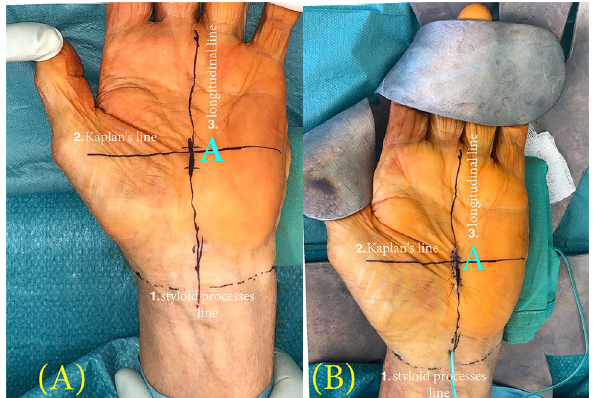
Figure 2. ( A ) Preoperative planning and ( B ) Postoperative result of MCTR: The following lines are drawn: 1. Horizontal line between both styloid processes 2. Horizontal parallel line—the Kaplans cardinal line: 3. Longitudinal line on the ring finger’s radial side. ( A ) The intersection point of these two lines (2. and 3.) marks the reference point for the skin incision. ( B ) The suture closuring of the mini-open procedure—which extends not more than 1–1.5 cm—and its localization are pictured. MCTR mini-open carpal tunnel